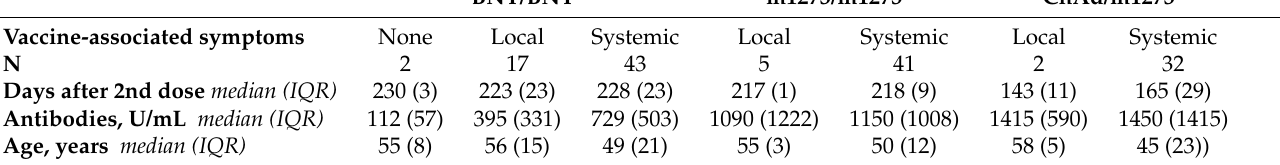
Figure 4. Concentration of antibodies against SARS-CoV-2 spike (S) protein in plasma 5 to 7 months after completion of vaccine regimen with the second dose of vaccine according to vaccine regimen and vaccine-associated symptoms (VAS). Results are presented as both individual values and as box plots, where the ends of the boxes define the 25th and 75th percentiles, and with a line at the median. Green circles: BNT/BNT, the BNT162b2 mRNA vaccine from Pfizer/BioNTech. Blue squares: m1273/m1273, the mRNA-1273 vaccine from Moderna. Purple diamonds: ChAd/m1273, the heterologous vaccine regimen combining ChAdOx1 vaccine from AstraZeneca with m1273 from Moderna. None refers to no VAS; Local refers to local VAS, and Systemic to systemic VAS. Interquartile range (IQR) indicates the difference between the 75th and 25th